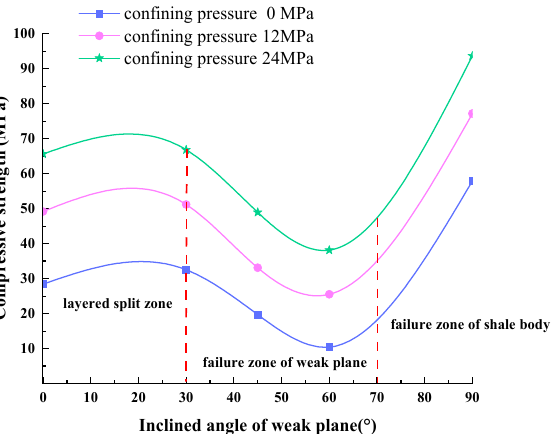
Figure 2. The relationship between the triaxial compressive strength and the angle between the loading pressure direction and the bedding direction.